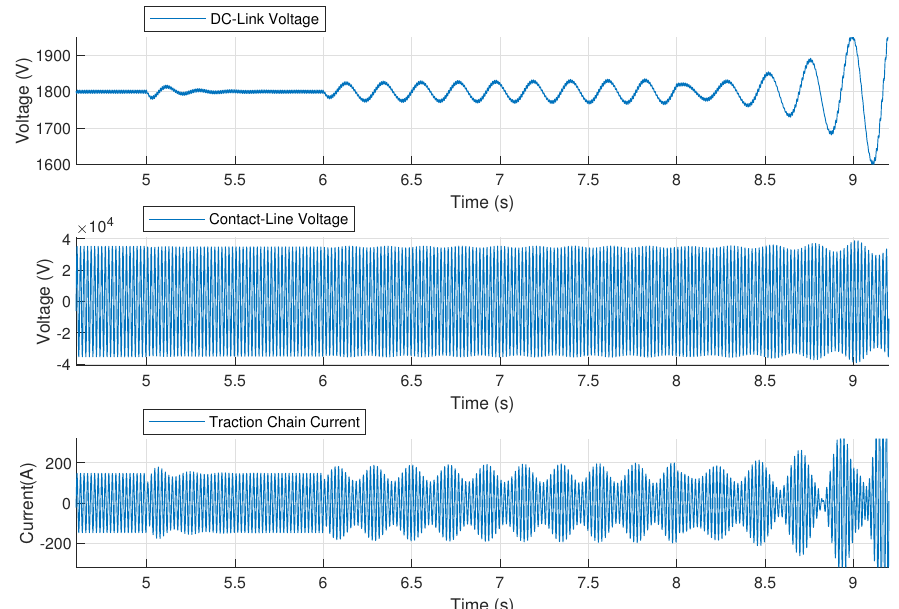
Figure 6. Time-domain simulations. From top to bottom: DC-link voltage, contact-line voltage and train current. Step changes of power supply impedance are consecutively applied along the simulation time. The stable case, stability limit case and unstable case are found at times t = 5 s, t = 6 s and t = 8 s, respectively.